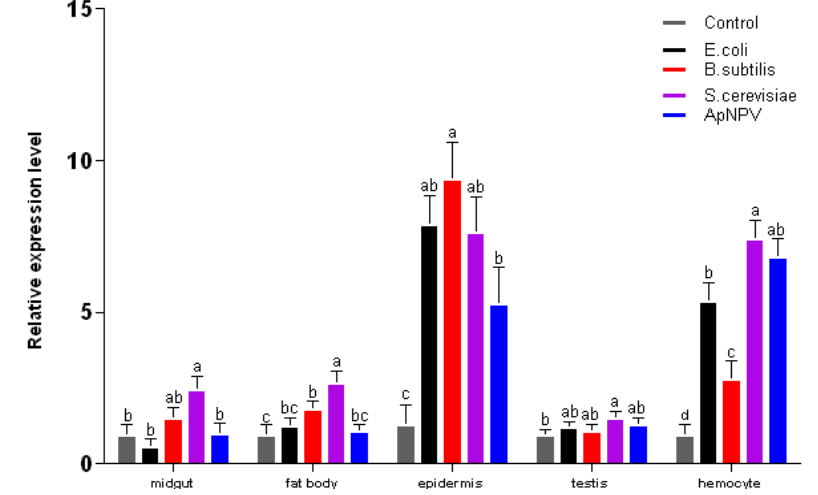
Figure 6. (cid:40)(cid:91)(cid:83)(cid:85)(cid:72)(cid:86)(cid:86)(cid:76)(cid:82)(cid:81)(cid:3) (cid:82)(cid:73)(cid:3) (cid:36)(cid:83)(cid:533)(cid:42)(cid:53)(cid:51)(cid:3) (cid:68)(cid:87)(cid:3) (cid:21)(cid:23)(cid:3) (cid:75)(cid:3) (cid:83)(cid:82)(cid:86)(cid:87)(cid:76)(cid:81)(cid:77)(cid:72)(cid:70)(cid:87)(cid:76)(cid:82)(cid:81)(cid:3) (cid:76)(cid:81)(cid:3) (cid:71)(cid:76)(cid:73)(cid:73)(cid:72)(cid:85)(cid:72)(cid:81)(cid:87)(cid:3) (cid:87)(cid:76)(cid:86)(cid:86)(cid:88)(cid:72)(cid:86)(cid:3) (cid:82)(cid:73)(cid:3) A. pernyi pupae. Different letters indicate significant differences in expression, p < 0.05. Error bars indicate standard deviation of three biological replicates.